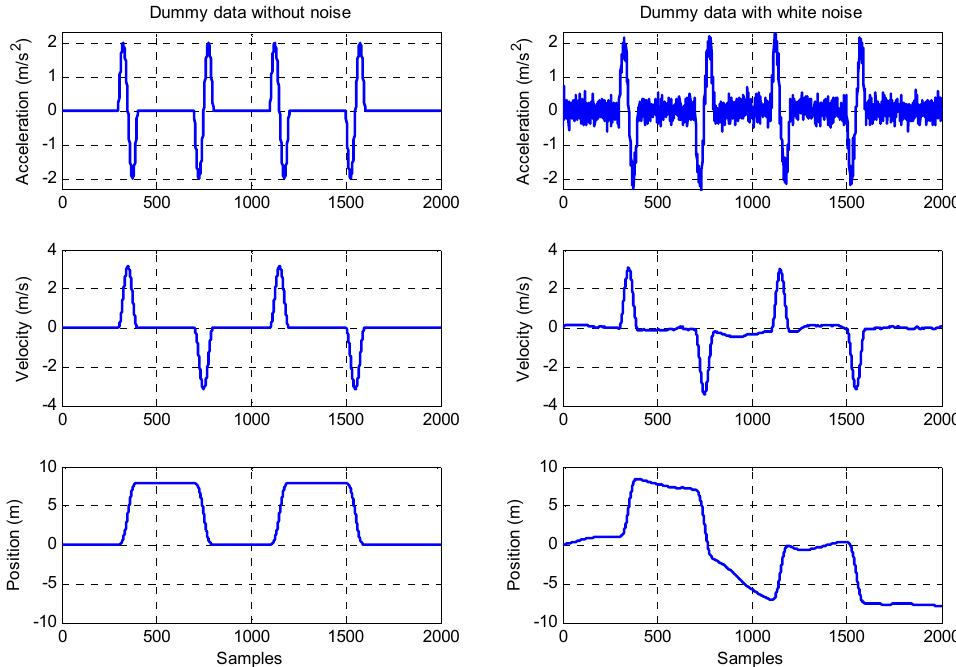
Sensors 2023 , 23 , x FOR PEER REVIEW Figure 2. Illustration DR algorithm using dummy data. Figure 2. Illustration DR algorithm using dummy data.